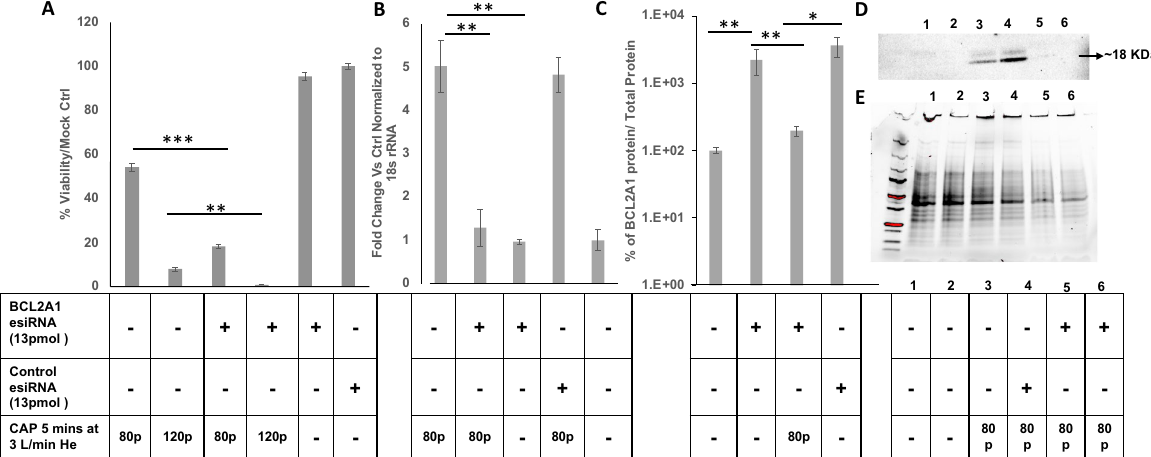
Figure 7. Silencing of BCL2A1 mRNA increases CHCP treatment potency. Bar graphs showing the ( A ) effects of BCL2A1 esiRNA silencing on cell viability and ( B ) the fold change of BCL2A1 mRNA and ( C ) protein expression in MDA-MB-231 cell line in combination with CAP treatment. At 24 h. after transfection with BCL2A1 esiRNA (13 pmol), as mentioned in the methods section survival of treatments was determined by MTT assay and BCL2A1 fold change by qRTPCR and western blots. ( D ) and ( E ) show a representative blot for BCLA1 and total protein respectively. The error bars represent means ± SEM. (n = 3). (****p < 0.0001, *p < 0.05,